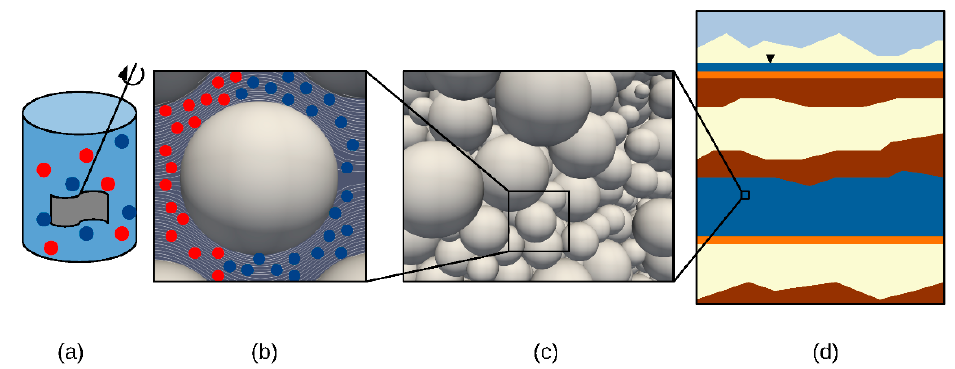
Figure 5. Mechanistic modeling approaches: ( a ) well-mixed batch system; ( b ) microscale modeling approach where the colored dots indicate reactive species; ( c ) a macroscale point, which can be resolved using microscale methods or averaged over at the macroscale; and ( d ) a field-scale system with a macroscale point denoted.